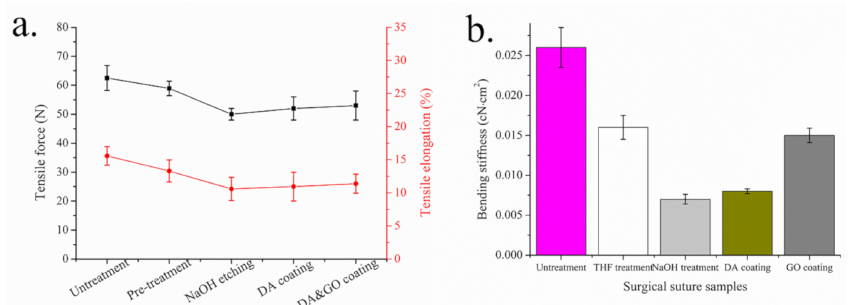
Figure 6. Tensile force, tensile elongation, and bending sti ff ness of the PGA multifilament surgical sutures. ( a ) Tensile force and elongation; ( b ) bending sti ff